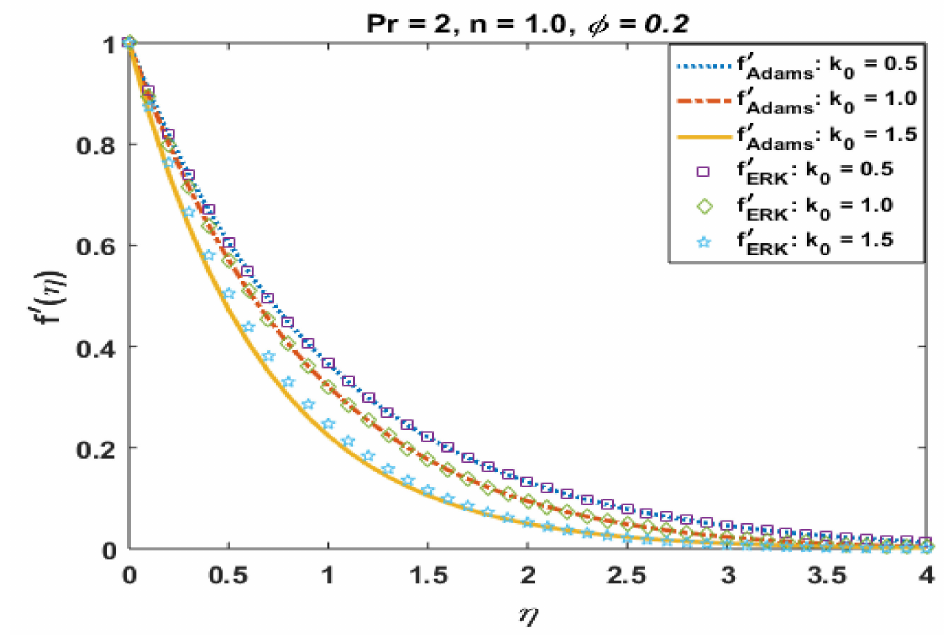
Figure 15. Effects of k 0 on f (cid:48) ( η )